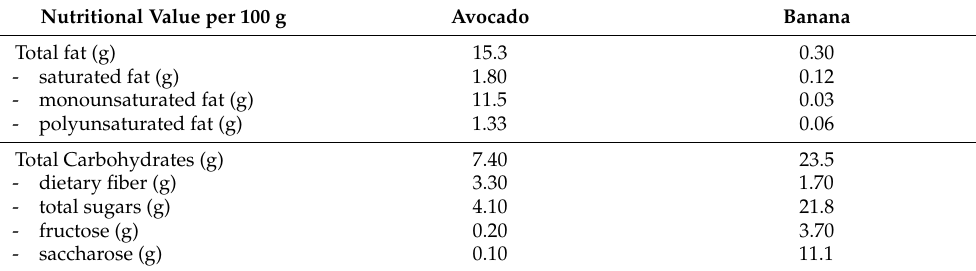
Table 1. Comparison of the nutritional value of avocado and banana based on the data in the food nutritional table [16].